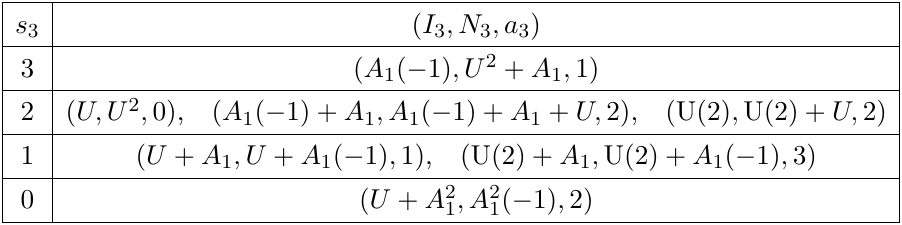
Figure 2 . Starting from the (2 , 0 , 0) model and shuffling A 1 lattices in the two E 8 components of Γ ’ Γ 0 = U 3 + E 2 as in table 2, we connect to models with I = U + K and a ≤ 8 . These (19 , 3) 8 models are located inside the dashed blue lines. Five points depicted as blue circles are not obtained in this way. Starting from (2 , 2 , 0) model and moving the A 1 lattices we connect to models with I = U(2)+ K and a ≤ 10 located inside the dotted red lines. The red dots and circles in this region may not be obtained in this way.